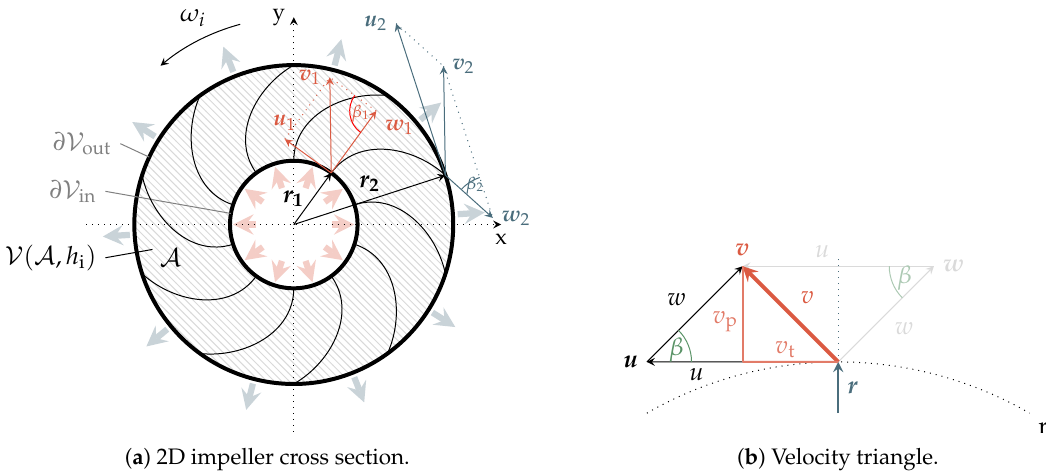
and ( b ) exemplary V